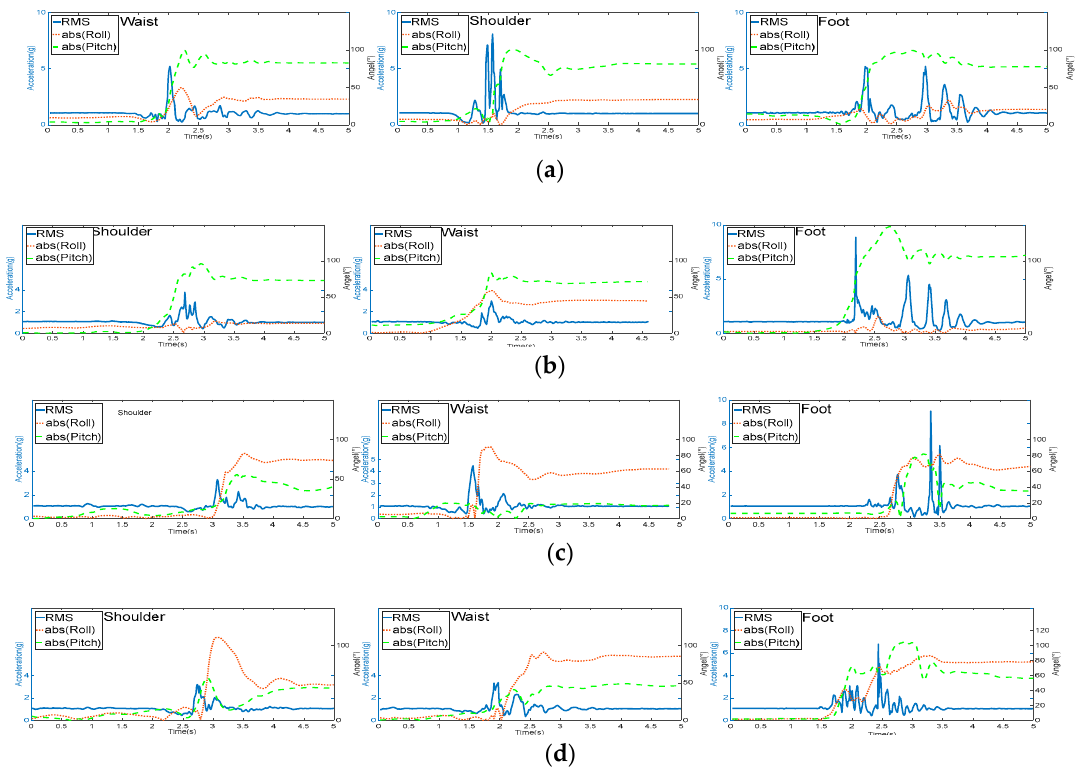
Figure 9. RMS and absolute value of roll and pitch distribution on the shoulder, waist, and foot during typical fall activities: ( a ) Backward fall ending up lying; ( b ) Forward fall ending up lying; ( c ) Lateral right fall ending up lying; ( d ) Lateral left fall ending up